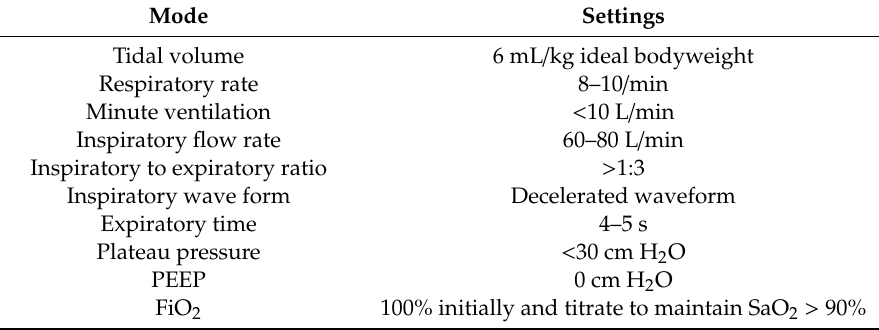
Figure 8. Flow time tracing of a patient with persistence of flow at the end of expiration which indicates dynamic hyperinflation and pressure time tracing with a slope increase indicative of over-distension. Table 4. Initial ventilator settings in intubated patients with acute severe asthma exacerbation.